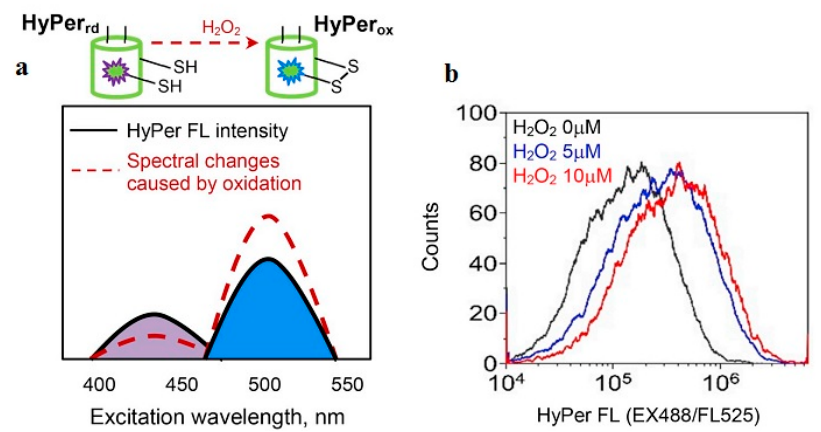
Figure 3. Analysis of HyPer fluorescence in K562 cells exposed to extracellular H 2 O 2 . ( a ) Scheme demonstrating the changes in the excitation spectrum of HyPer upon oxidation. ( b ) Flow cytometry histograms of K562 cells measured after two-minute exposure to different concentrations of H 2 O 2 . Reproduced with permission from [127]. Copyright 2019, Science Direct (Amsterdam, The Nether- lands).